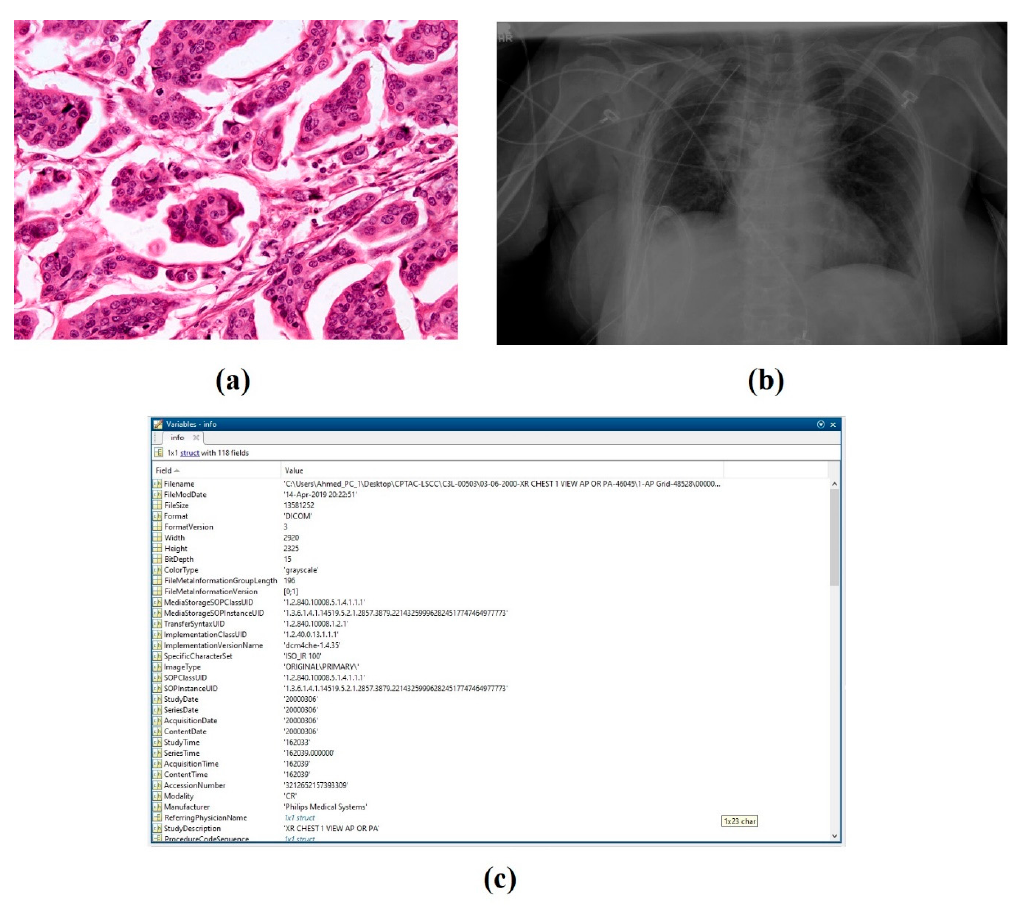
Figure 6. The original data used. ( a ) Pathological microscope images; ( b ) MRI images; ( c ) digital Figure 6. Theoriginaldataused. ( a )Pathologicalmicroscopeimages;( b )MRIimages;( c )digitalpatientrecords. Appl. Sci. 2019 , 9 , x FOR PEER REVIEW patient records.